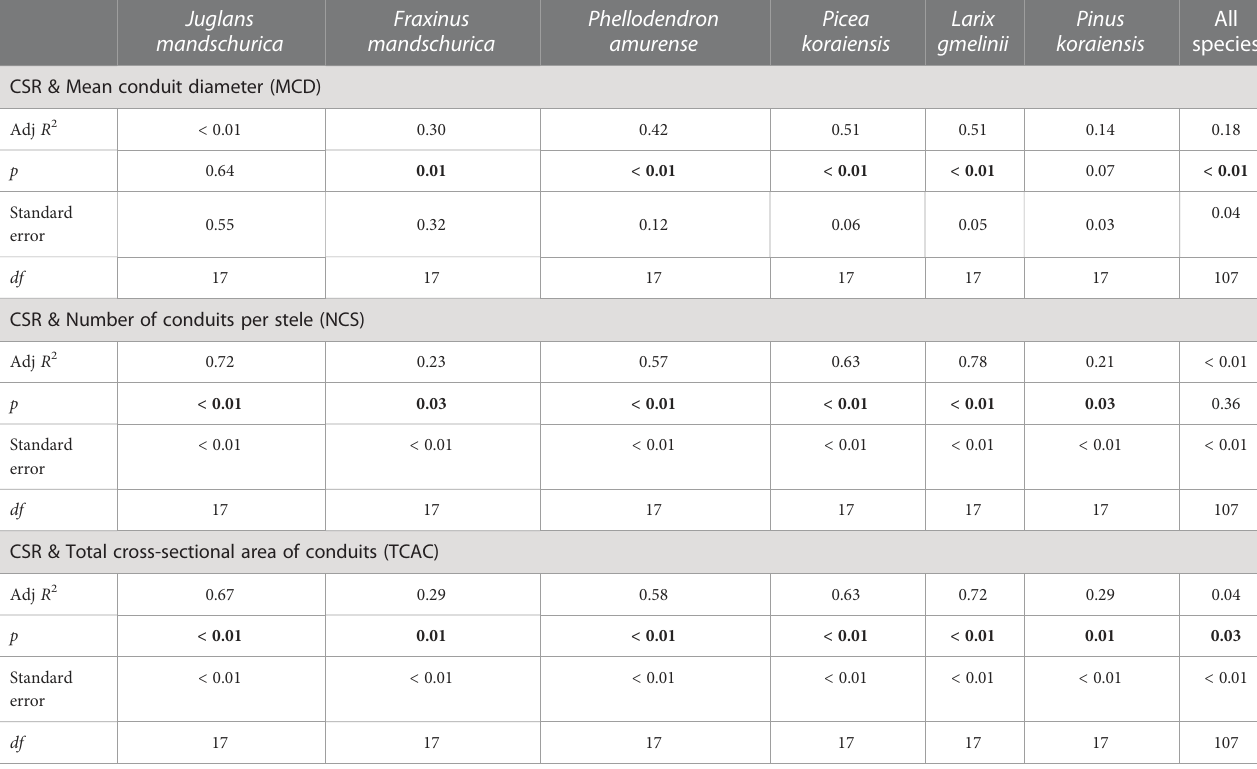
TABLE 4 Group-wise regression of the ratio of unilateral cortex thickness to stele radius (CSR) and conduit traits in three angiosperms and three gymnosperms tree species. Juglans